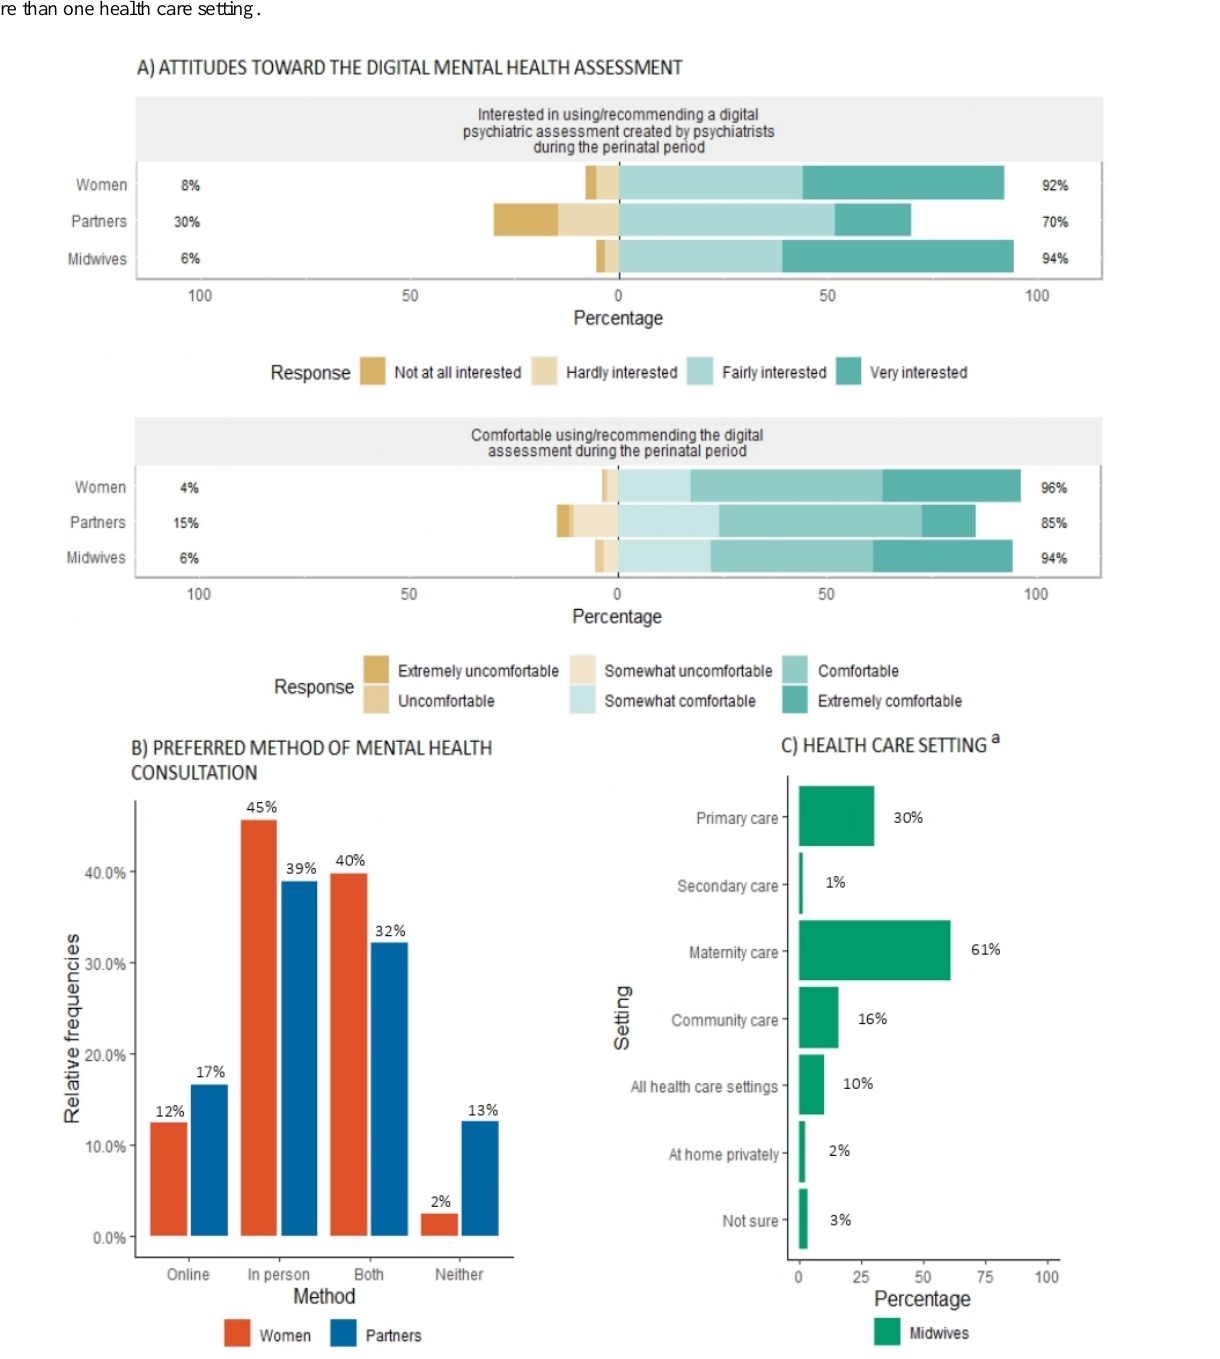
Figure 6. Interest in a digital mental health assessment to screen, diagnose, and triage perinatal mental health symptoms, including respondents’interest in using or recommending a digital mental health assessment throughout the perinatal period (A), women’s and partners’ preferred method of mental health consultation following a suggestion by the digital mental health assessment that a follow-up assessment is recommended (B), and midwives’ responses as to where they see the digital mental health assessment working best (C). a: Percentages add to more than 100% as some midwives suggested more than one health care